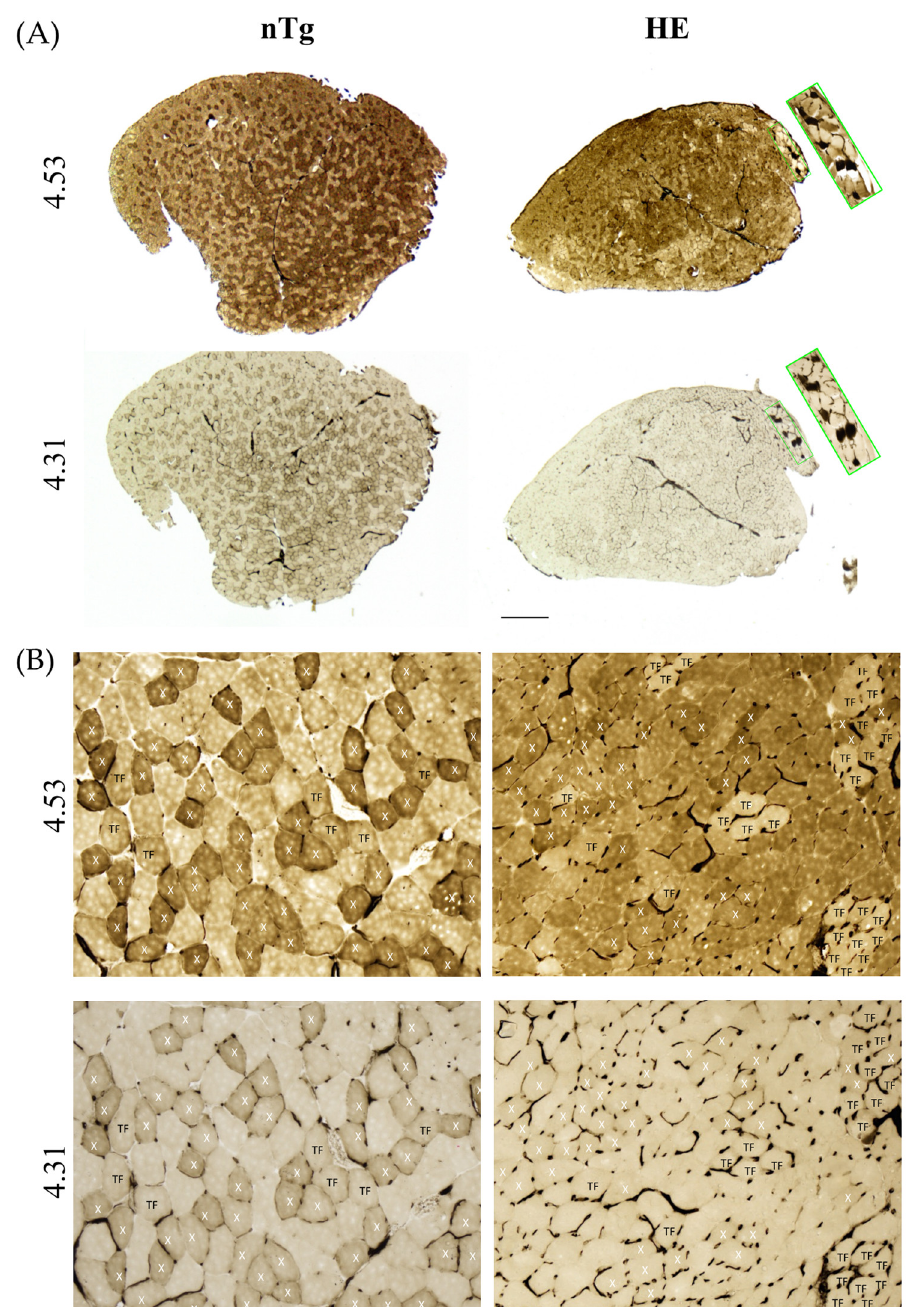
Figure 10. Representative micrographs of serial sections of TA from 24-month-old HE and nTg mice after myofibrillar ATPase histochemistry. Serial sections were either preincubated at pH 4.53 or at pH 4.31. At pH 4.53 and pH 4.31, type 1 fibers are black. At pH 4.53, type 2B fibers are brown, type 2A fibers are the lightest, and type 2X fibers appear dark brown. At pH 4.31, type 2X fibers are light brown and type 2A and 2B fibers are the lightest/colorless. X indicates 2X fiber type, and TF corresponds to transition fibers light brown at pH 4.53 and light/colorless at pH 4.31. ( A ) Low magnification. The inset shows the presence of some type 1 fibers. Scale bar: 500 µm. ( B ) High magnification of the sections presented in ( A ), scale bar: 50 µm. Note the grouping of TFs in HE mice and the more homogeneous brown staining, making it difficult to identify fiber types. Scale bar: 50 µm.